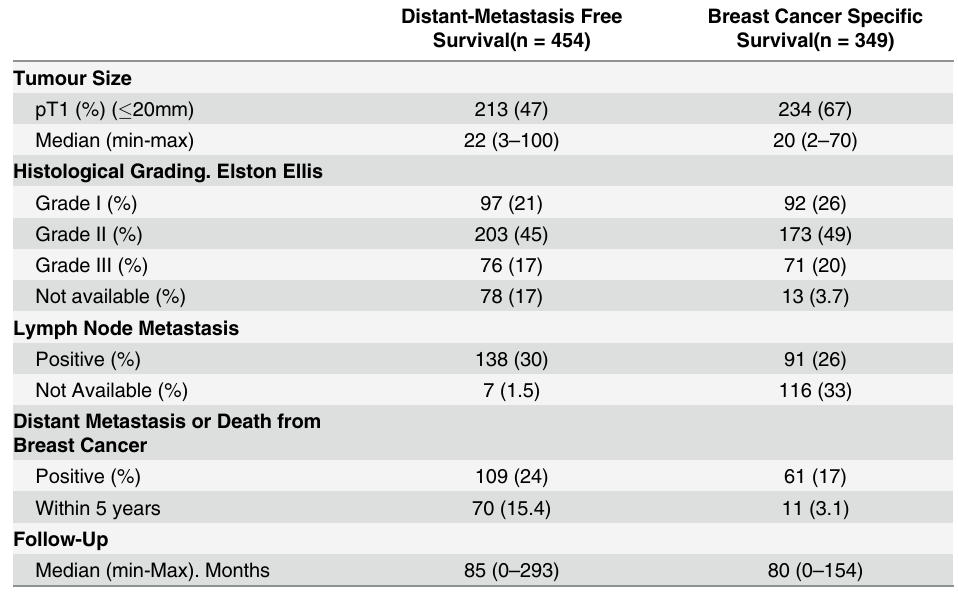
Table 1. Clinical, histological and molecular signatures of 769 ER-positive HER2-negative patients presenting breast carcinoma *